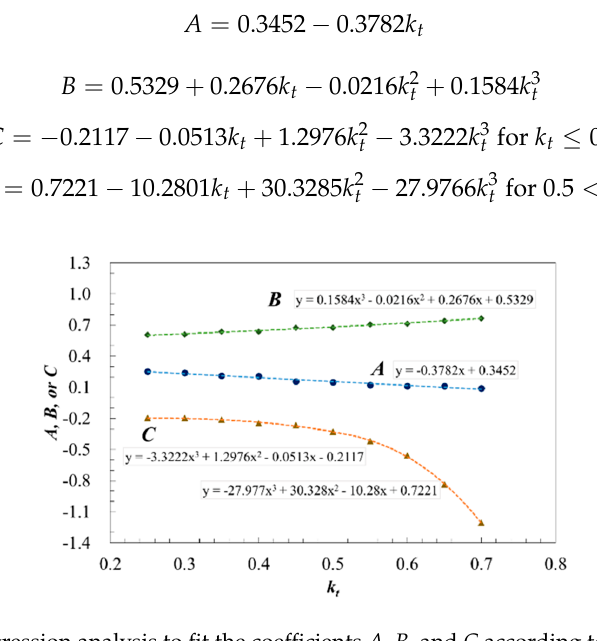
Figure 4. Regression analysis to fit the coefficients A , B , and C according to Equation (8).